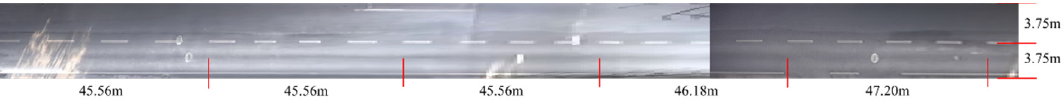
Figure 14. The panoramic image of actual road scene.